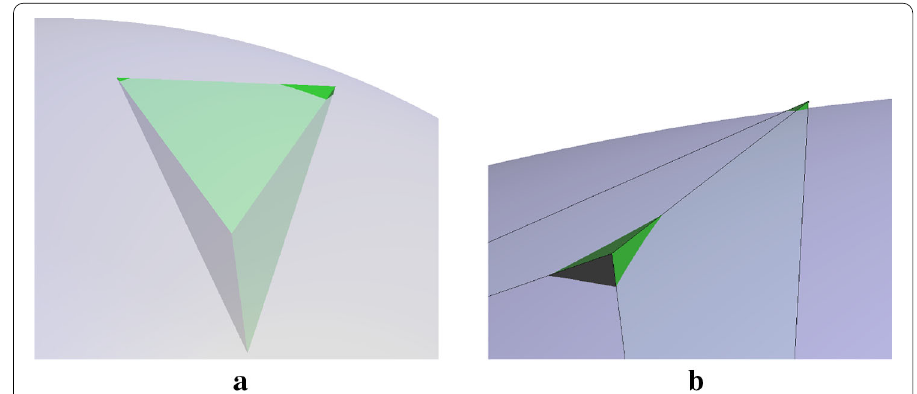
Fig. 13 Special intersection pattern for curved geometries in which edges of the background mesh are intersected twice. a 3D example. b Close-up of the same